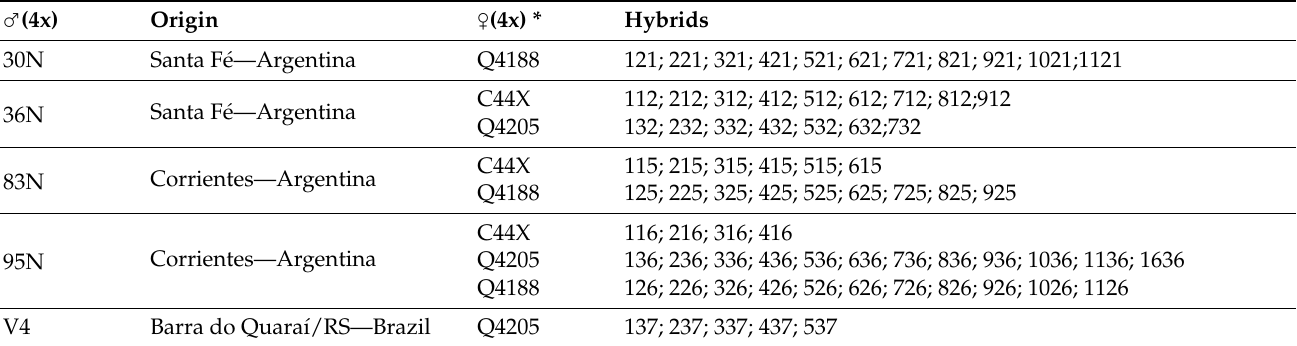
Table 1. Identification of male ( of Paspalum notatum